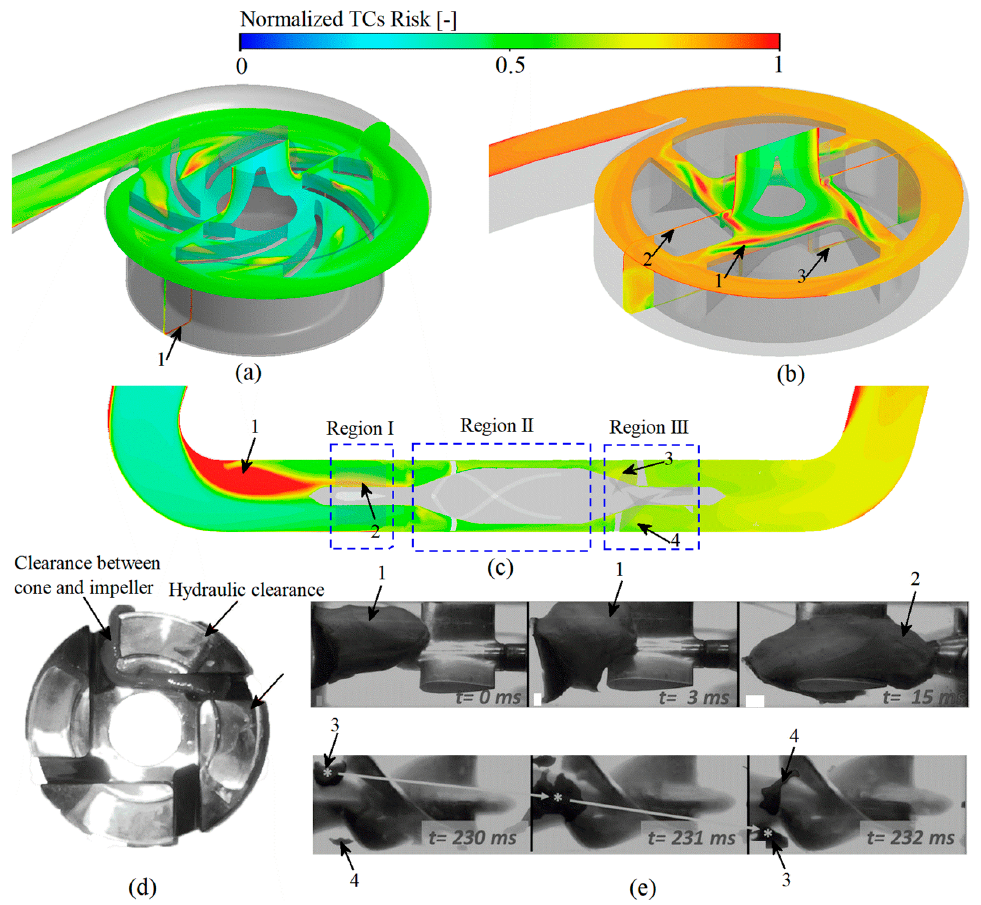
Figure 10. High thrombosis risk regions predicted of the studied VADs: ( a ) Simulation prediction of CH-VAD; ( b ) Simulation prediction of HVAD; ( c ) Simulation prediction of HM II; ( d ) Experimental prediction of HVAD, this picture is reproduced from the study performed by Schalit et al. [4]); ( e ) Experimental prediction of HM II